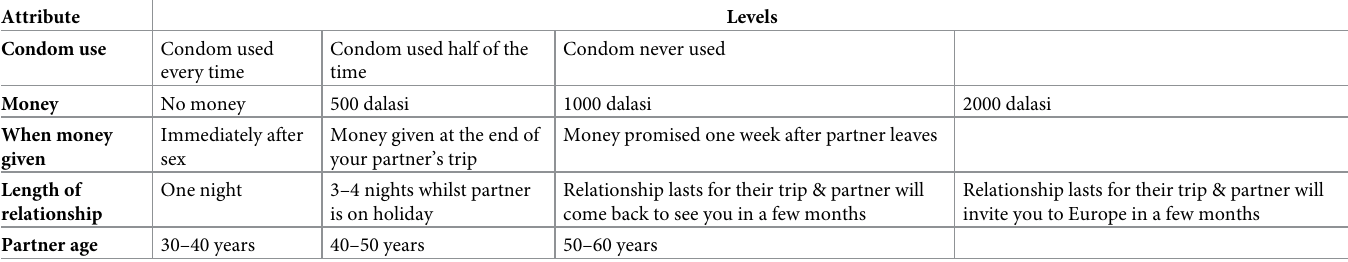
Table 1. Discrete choice experiment attributes and